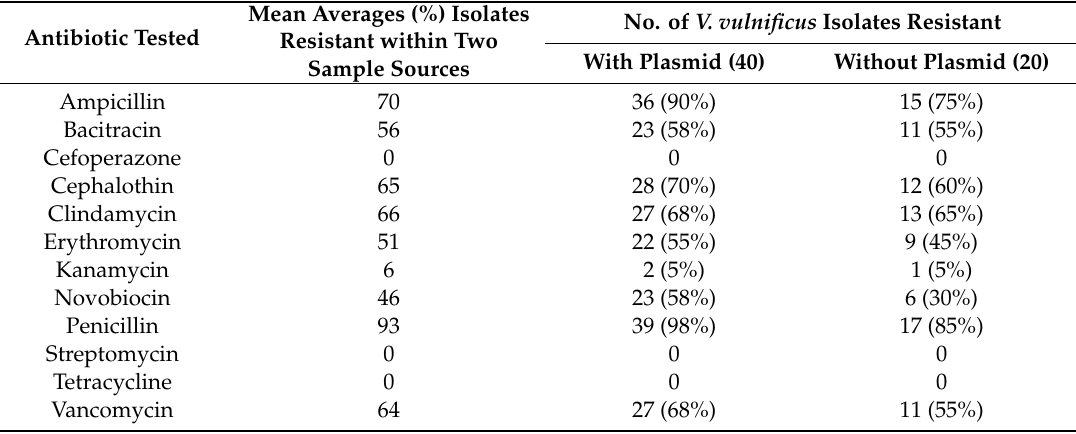
Figure 3. Example of plasmid profiles of Vibrio vulnificus isolated from Qatar (strain 47–60, Qatar) using a PureYield ™ Plasmid Miniprep System on 1% ( w / v ) agarose gel. Lane M: Lambda DNA-HindIII Digest DNA ladder. Lane 47–60: V. vulnificus strain 47–60; NC: negative control. Table 4. Antibiotic resistance and plasmid occurrence of Vibrio vulnificus isolates from cockle and clam samples purchased from wet markets in Malaysia and Qatar, respectively.